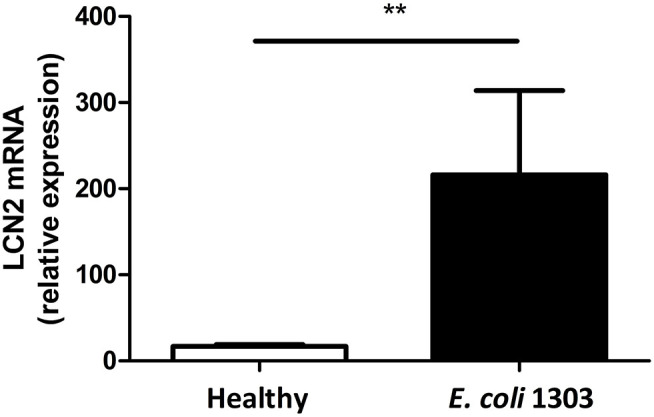
mRNA lipocalin 2 (LCN2) relative expression calculated by the ΔΔCt method taking as reference genes PPIA and 18S in udder quarters 24 h.p.i. with 500 colony-forming units (CFU) E. coli 1303 compared with sham-inoculated udder quarters (nquarters = 5 per condition). Data are presented as means ± standard error of the mean. **P < 0.01.